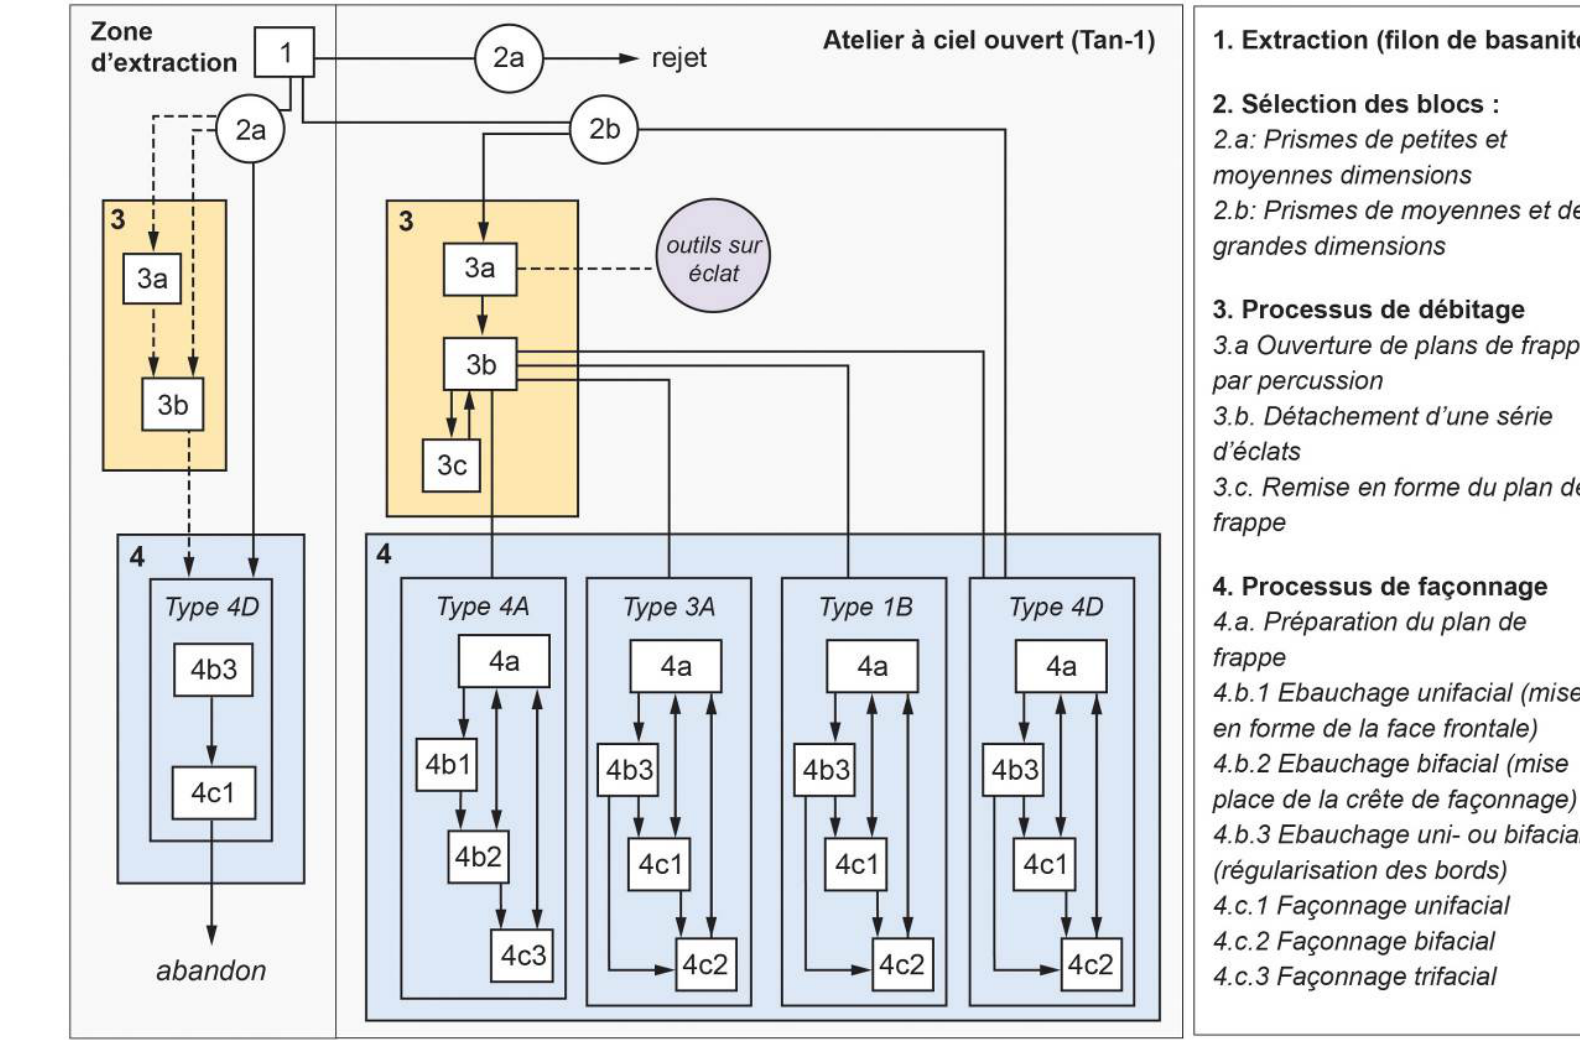
Figure 15. Chaînes opératoires de production des lames d'herminette à Tanataetea. Figure 15. Production processes of stone adze blades at Journal of Lithic Studies (2017) vol. 4, nr. 2, p. xx-xx doi:10.2218/jls.v4i2.2546